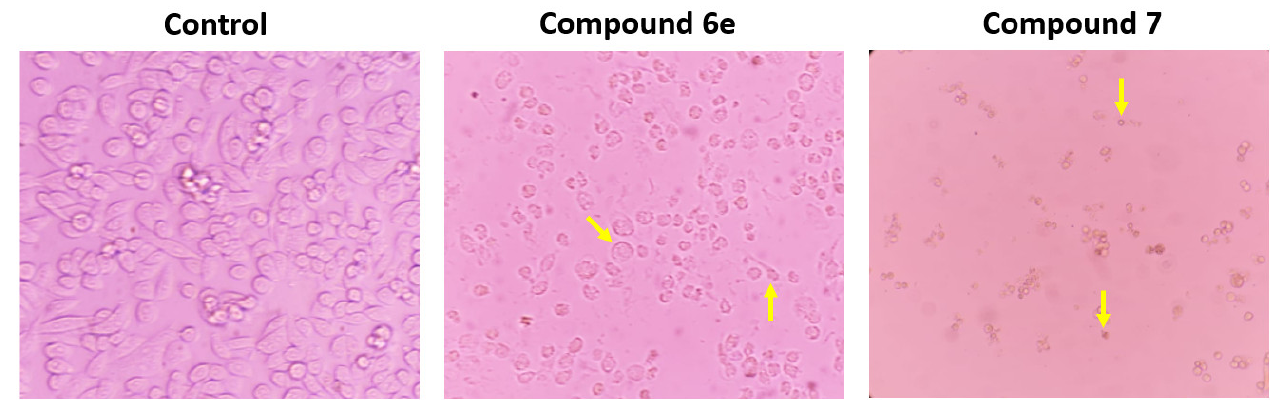
Figure 4. Representative images of SW480 cells 48 h after treatment with hybrid 6e and 7 . Arrows indicate changes in size and shape. Magnification: 40× .